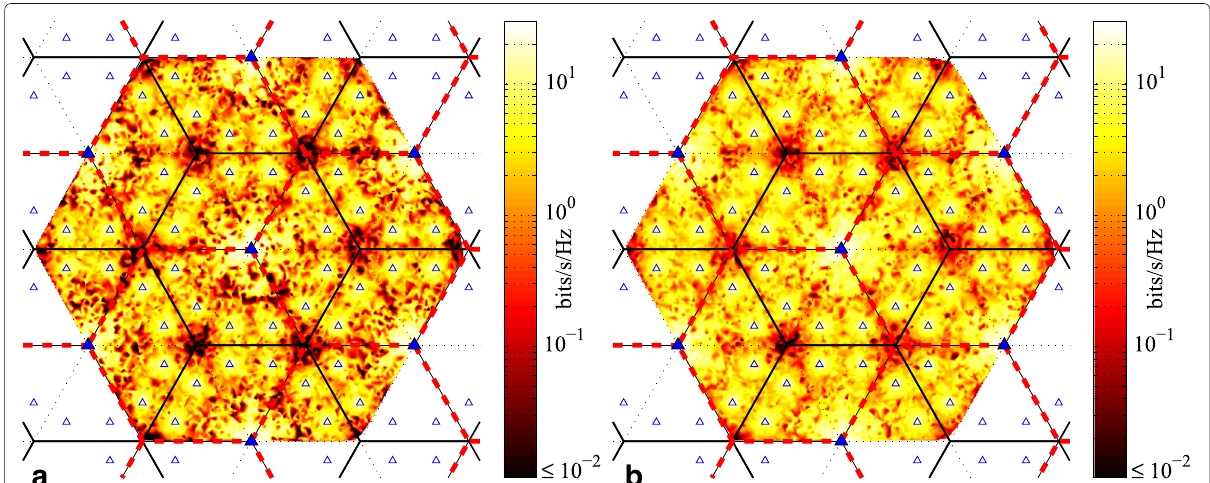
a b Fig. 7 Average achievable rate per user based on user position within cellular network, with MT scheduling metric for six-cell layout, using simulated annealing scheduling and SZF-DPC precoding; N macro = N pico = 2, M = 2, K c = 12. a Fixed clustering. b Rotating clustering ( T cl = 100)